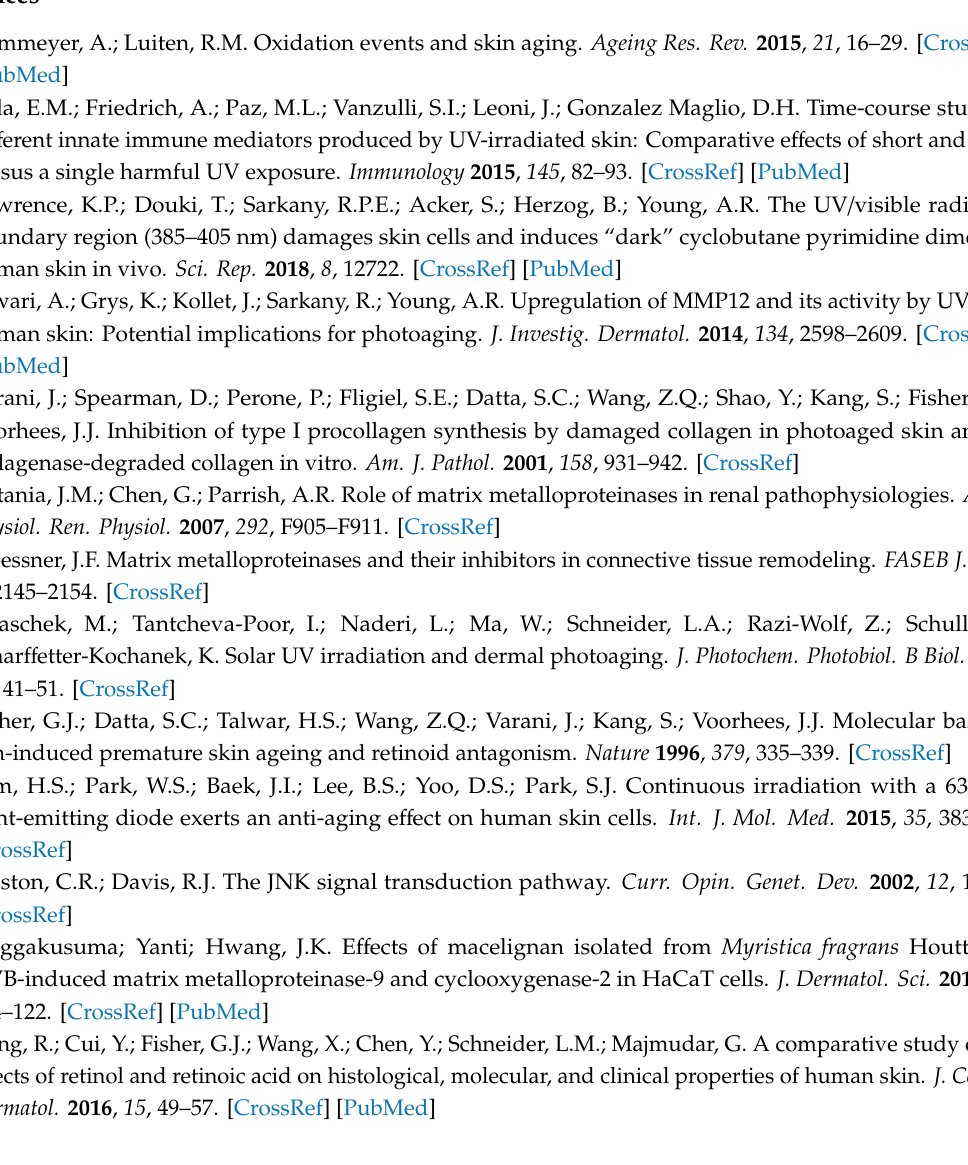
Figure S1: Cell viability UVB-irradiation. HaCaT cells (1 × 105 cells / mL) were seeded in a 96-well plate and treated with UVB-irradiation at 20, 30, 40 and 50 mJ / cm 2 . The cell viability was determined using the MTT assay, Figure S2: The e ff ects of UVB-irradiation on the phosphorylation of MAP kinase in HaCaT cells. HaCaT cells (1 × 105 cells / mL) were seeded in a 6-well plate and treated with UVBirradiation at 40 mJ / cm 2 and the protein was extracted after 15, 30, 60 and 120 min Protein expression was confirmed by western blot, Table S1: List of the primer sets used in this study, Table S2: List of antibodies used in this